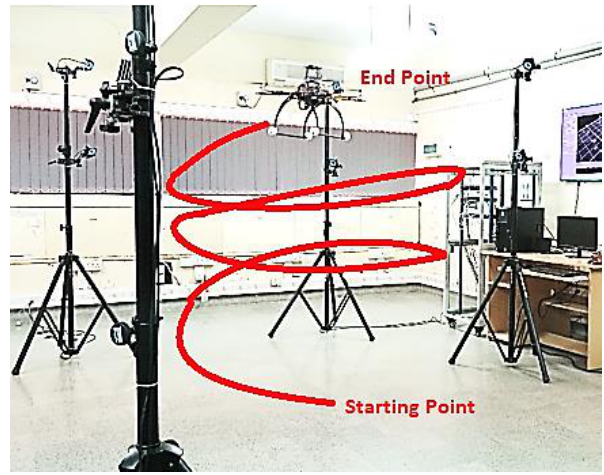
Figure 25. Flight mode of quadrotor within a closed environment.